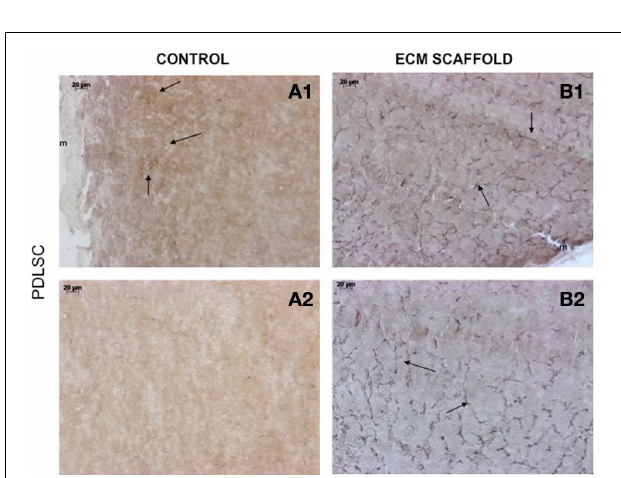
FIGURE 10 | PDLSCs in ECM scaffold: von Willebrand factor (VWF) immunohistochemistry. The micrographs are representative images of VWF stained explant sections containing PDLSCs (A,B) in control and pulp ECM scaffolds. In all the images, 1 and 2 nomenclature indicates micrographs that show expression of VWF in the periphery (1) and within (2) the respective scaffolds. The arrows in the images point to positively stained endothelial cells and capillary networks. Note the absence of positive staining in the interior of the control scaffolds containing PDLSCs (A2) , and positive staining in the periphery of the control scaffolds (A1) . The scale bar in all the images represents 20 μ m.